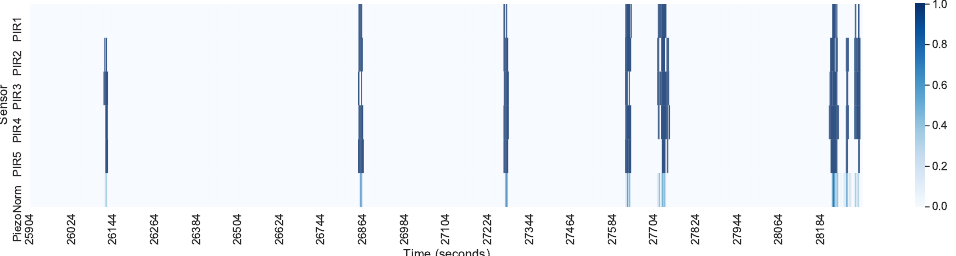
Figure 9. PIR and piezoelectric sensor activation (the last 40 min of the 8 h of